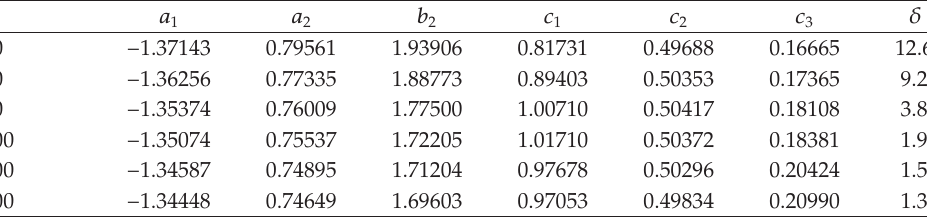
Table 4: The parameter estimates (cid:2) θ s (cid:3) (cid:2) σ 2 (cid:7) 1.50 2 , δ ns (cid:7) 32.87% (cid:3) .